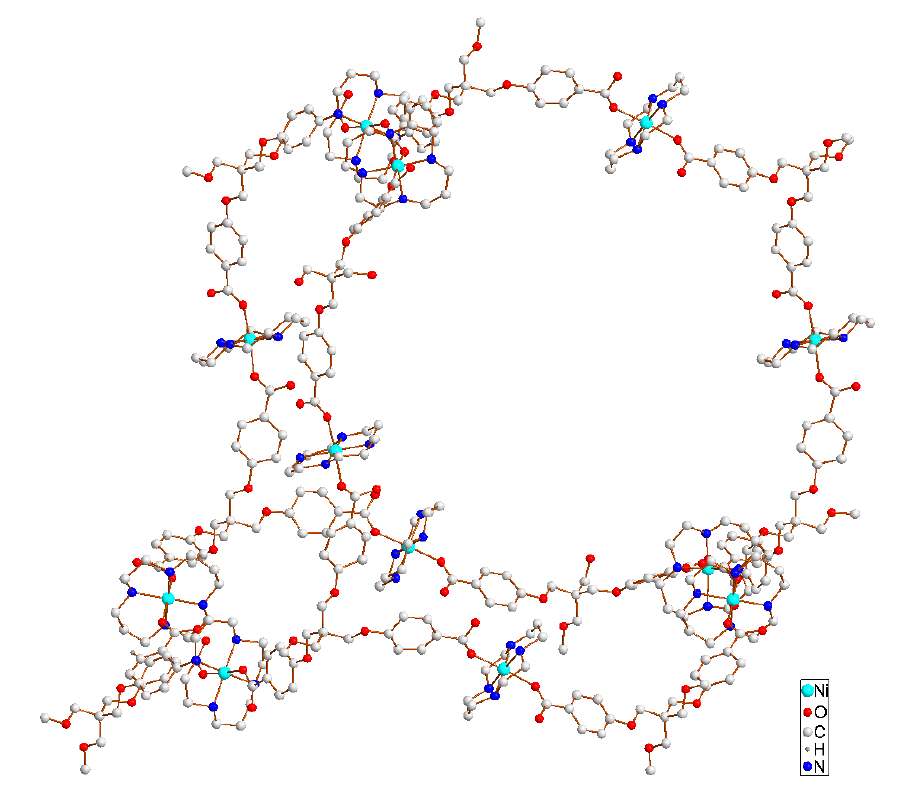
Figure 5. View of the adamantantoid cage in the crystal of [Ni(cyclam)]